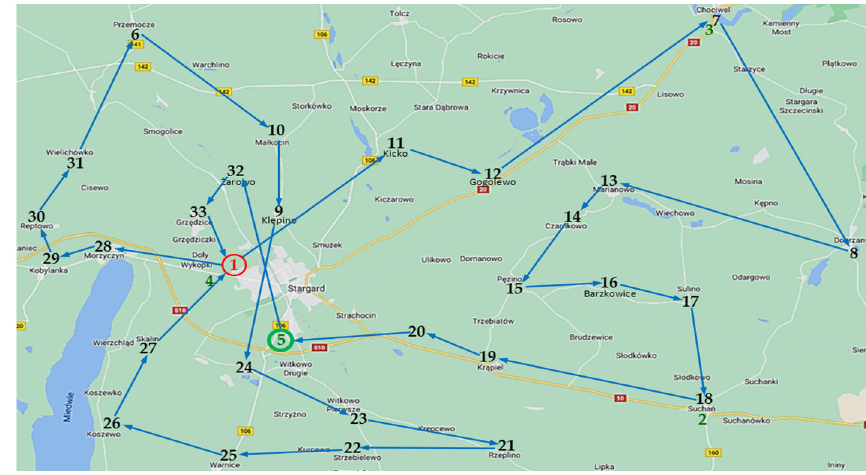
Figure 7. The visualization of the found solution for the second scenario.